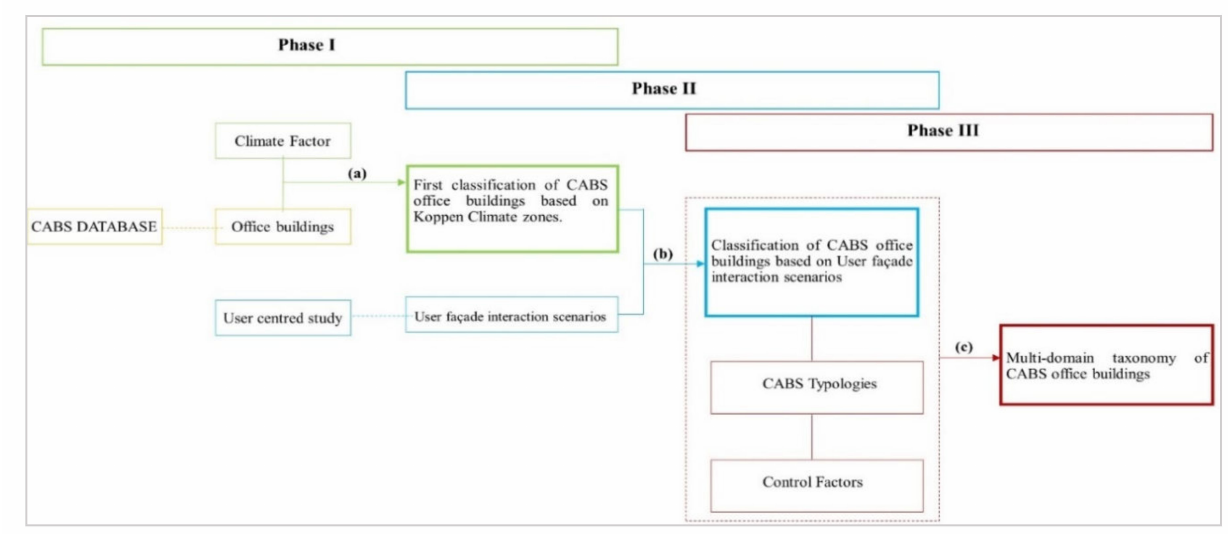
Figure 6. Structure of the case study (Authors,